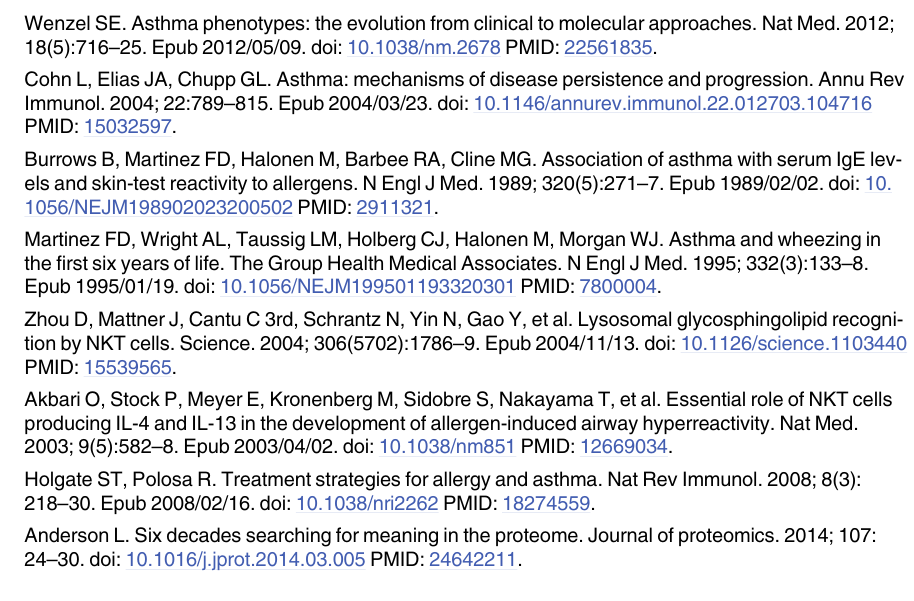
S1 Fig. BALF cytospin and H&E staining of lungs. A representative microscope image of MGG-stained, cytospinned BALF samples from WT mice which were treated with vehicle (DMSO) or with α -GalCer ( α GC). Immunohistochemical staining was performed on lung sec- tions from CD1 -/- and J α 18 -/- mice after vehicle or α -GalCer-treatment ( α GC). Only one sam- ple is shown as an example and there were 8 mice/group. S2 Fig. RT-pcr analysis of lung and BALF cells. Messenger-RNA expressions of validated CXCL15 and CLCA1 proteins by RT-PCR from lung specimen (A) and from BALF (B) cells. In both cases, samples are collected 24 hours after intranasal